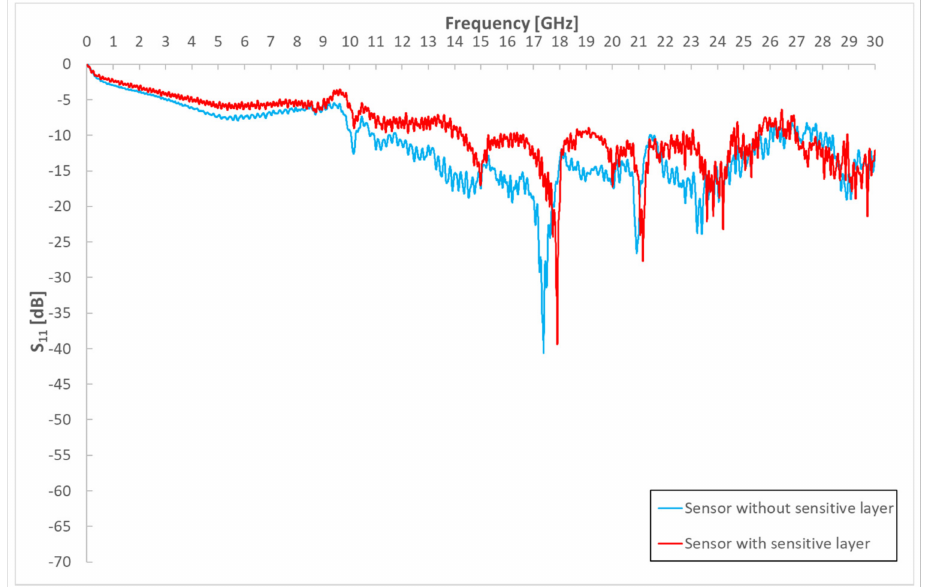
Figure 7. Influence of sensitive layer on S 11 parameters for sensor with space between electrodes of 100 µ